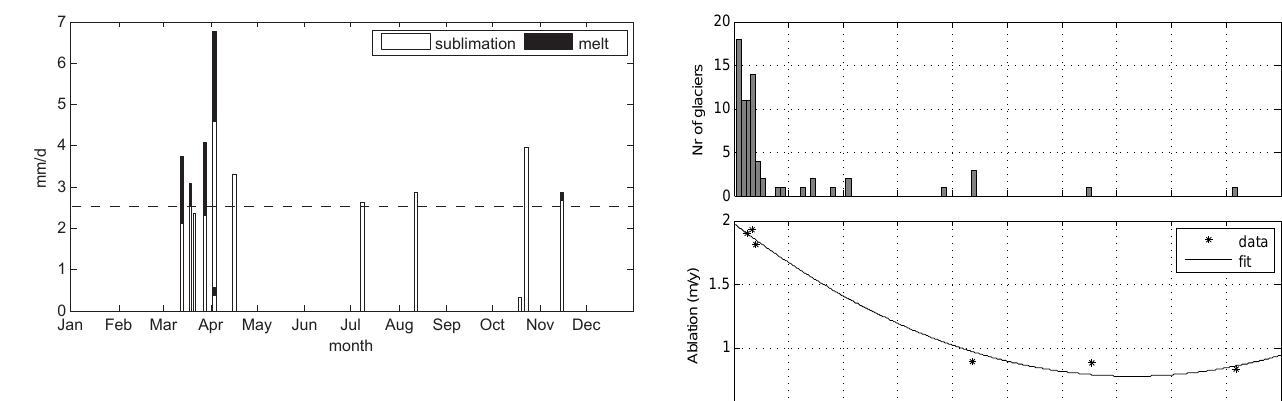
Fig. 3. Ablation, sublimation and melting rates from lysimeter ex- periments (mmw.e.d − 1 ). Dotted line: mean sublimation rate.